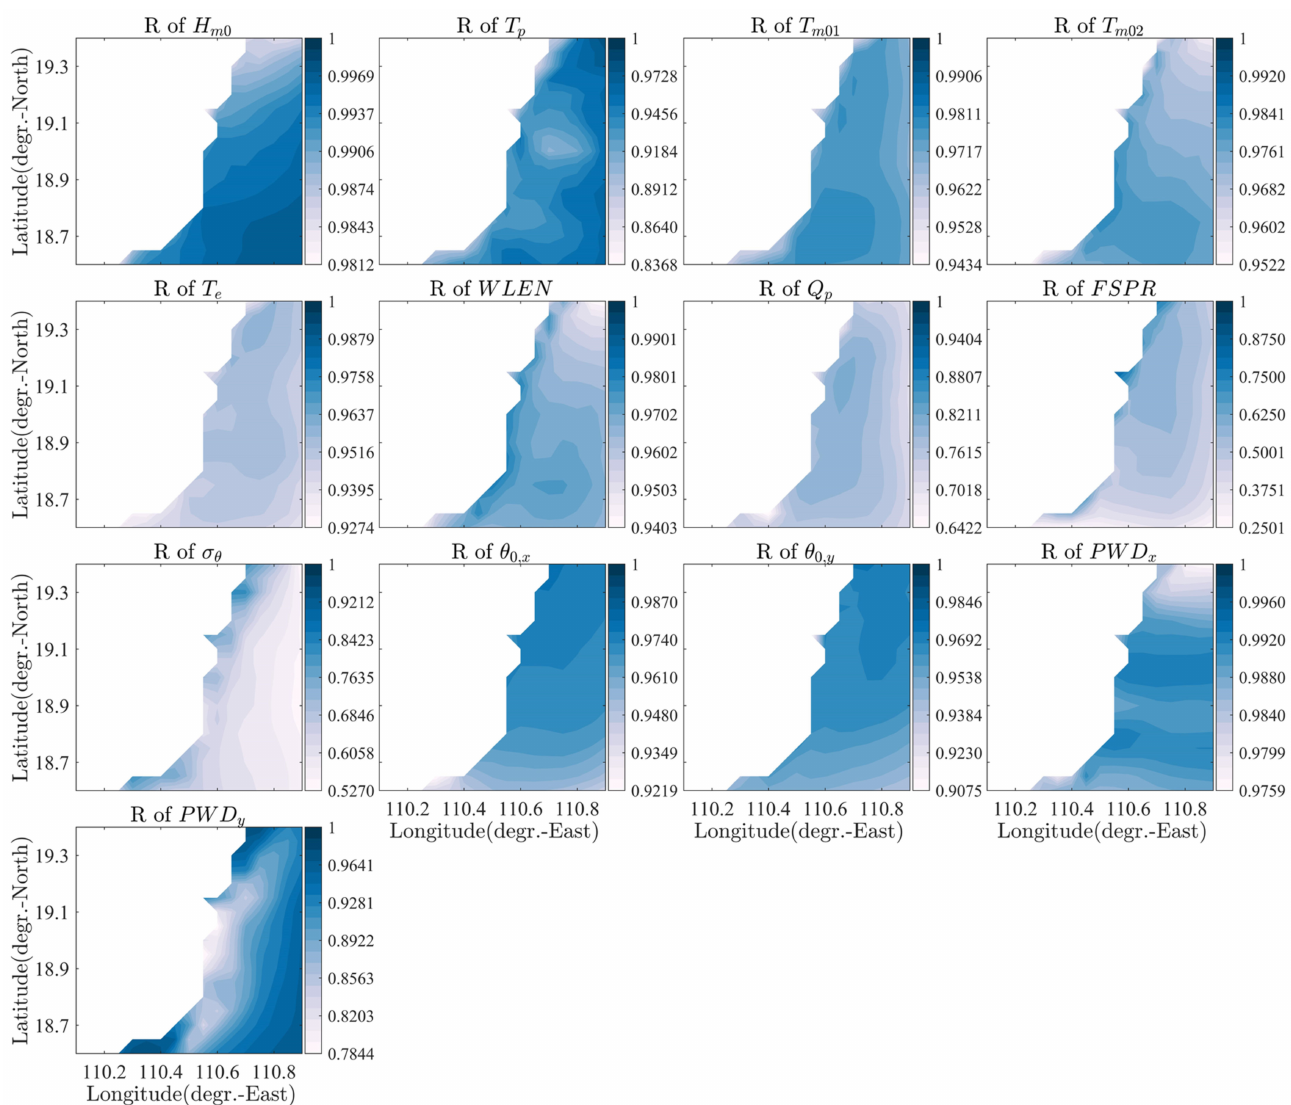
Figure 11. Spatial distributions of R of the KPs derived from the SWAN BLOCK outputs simulated with the original and the TMA–Mitsuyasu reconstructed boundaries. In each panel, the values of R are indicated by the colors, the title identifies the corresponding KP, and the x and y axes denote the longitude ( ◦ E) and latitude ( ◦ N),